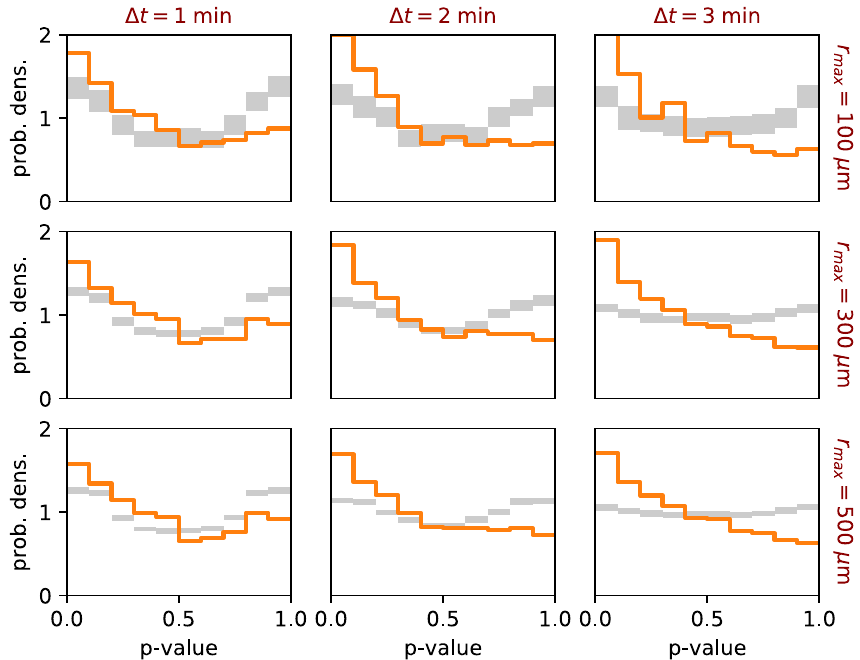
Figure 3. Application of the p value method to data simulated in the SGS model, using different recording intervals (cid:31) t (columns) and maximum interaction distances r max (rows). The differences between the simulated and reference data are more pronounced for larger recording intervals. Increasing the maximum interaction distance helps to reduce the width of the confidence interval in the reference distributions.